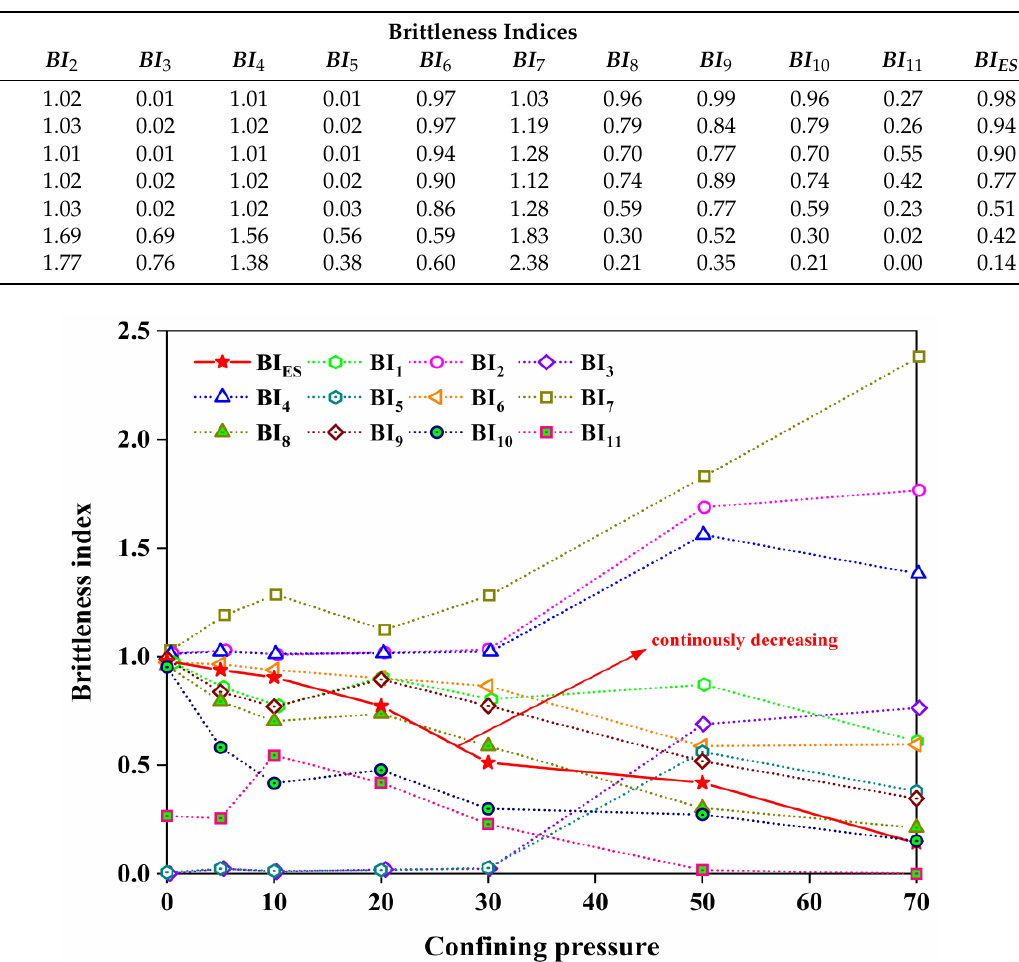
Table 7. Calculated results of various brittleness indices based on shale CTC test data.